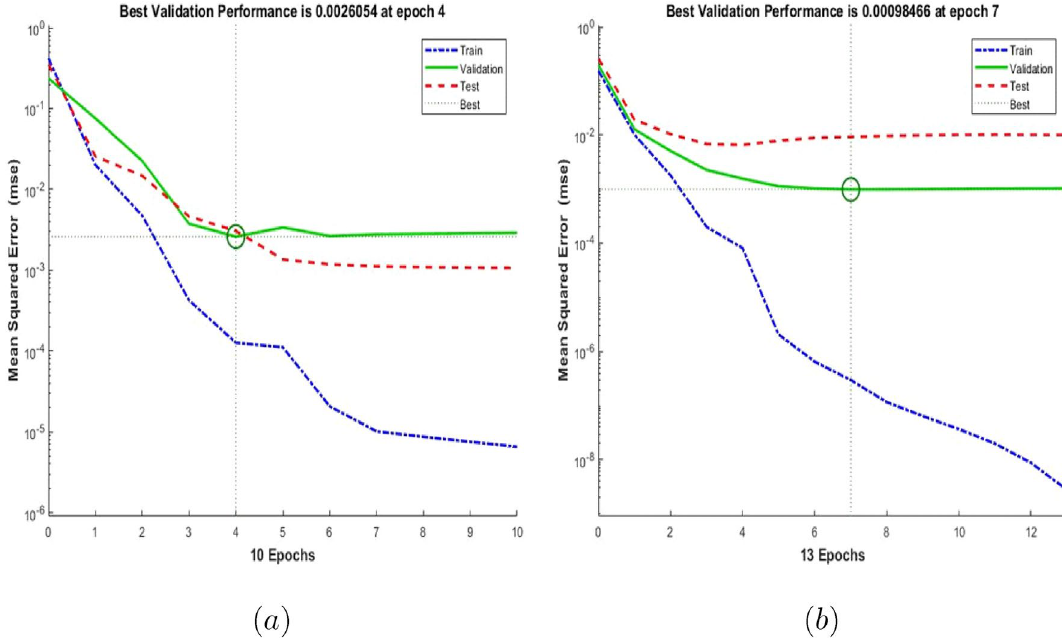
Figure 16. Performance of the ANN ( a ) Skin Friction Coefficients ( b ) Nusselt Number.